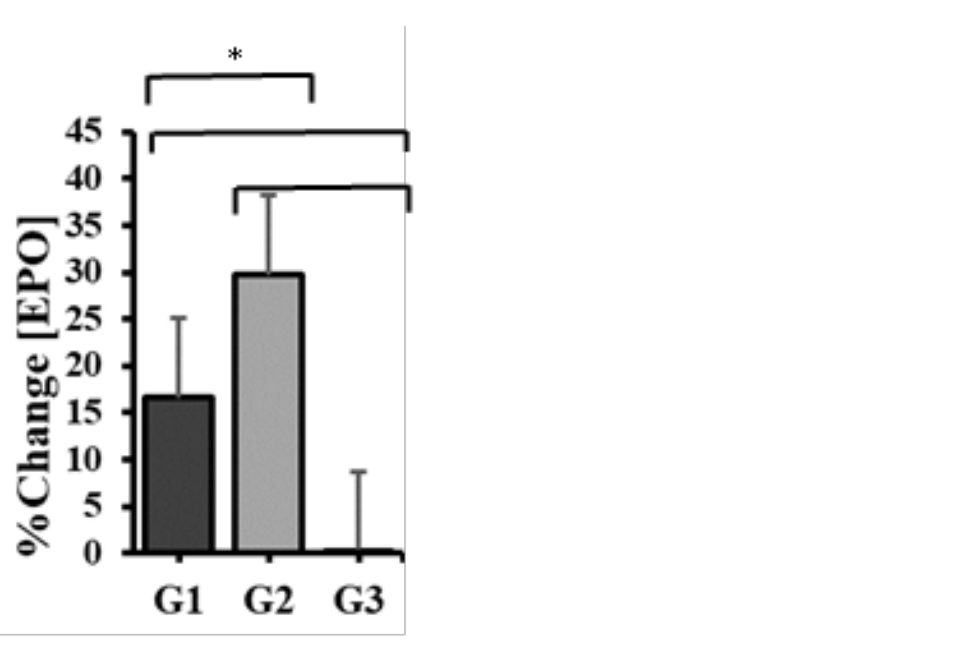
Figure 3. Relative before–after changes in EPO concentration, after 30 days of training at 2000 m altitude (G1), living at 1850 m and training at 2200 m (G2), namely 300 m (G3). Values displayed are mean ± sd. Significant differences (p < 0.05) between training courses are marked with *.